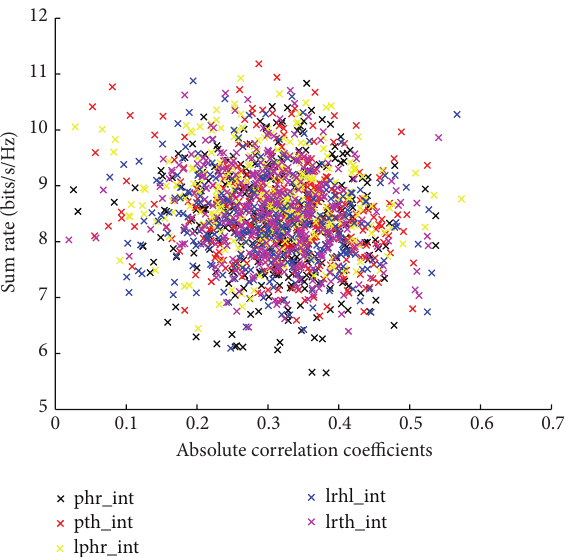
Figure 10: Scatter plot: capacity versus correlation for interference links at high band.